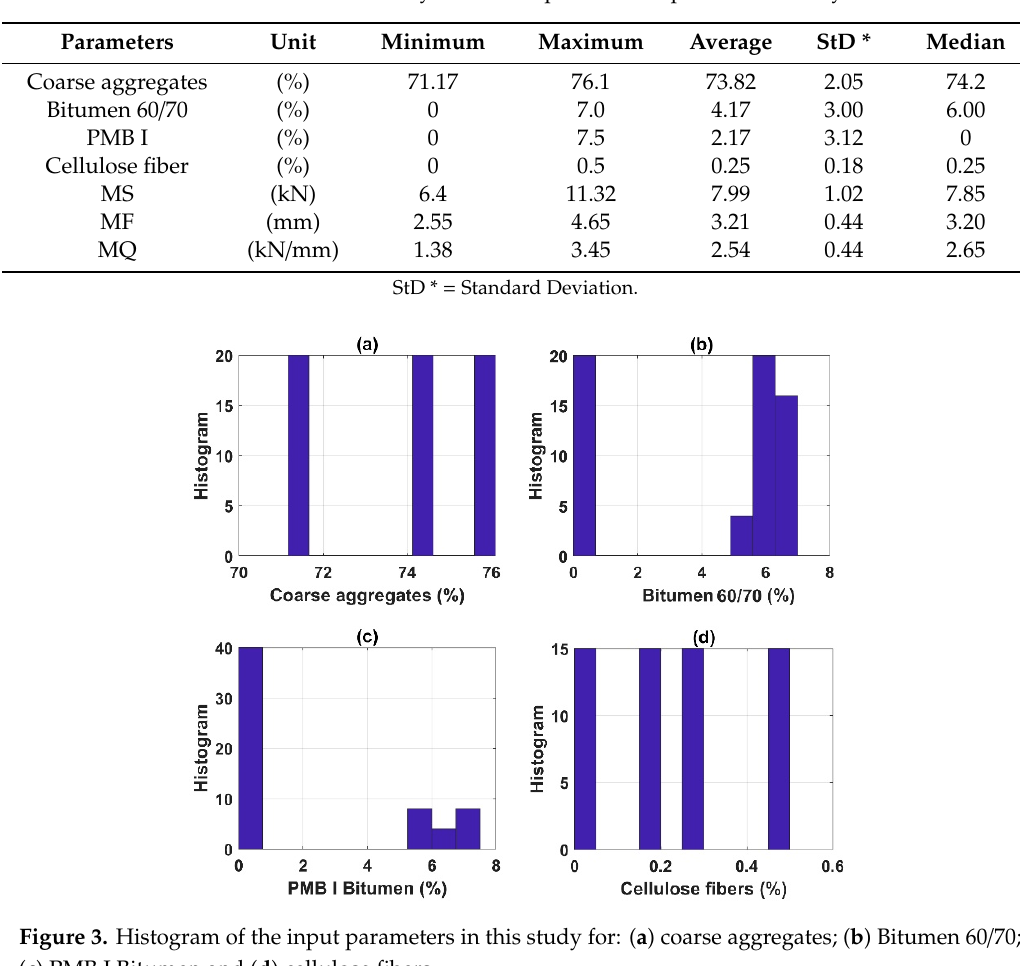
Table 4. Statistical analysis of the inputs and outputs in this study.